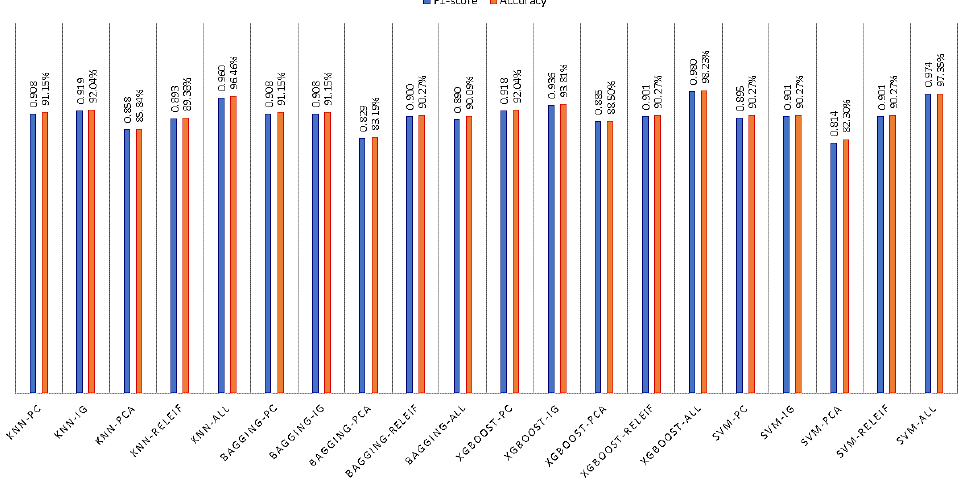
Figure 5. F1-score and Accuracy values of k-NN, Bagging, XGBoost and SVM with 80–20% split and five FS